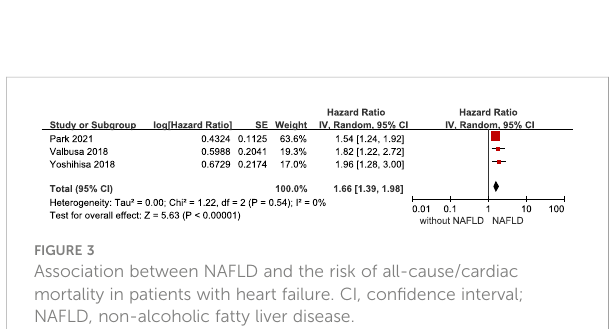
FIGURE 2 Association between NAFLD and the risk of primary adverse outcomes in patients with heart failure. CI, con fi dence interval; NAFLD, non-alcoholic fatty liver disease.